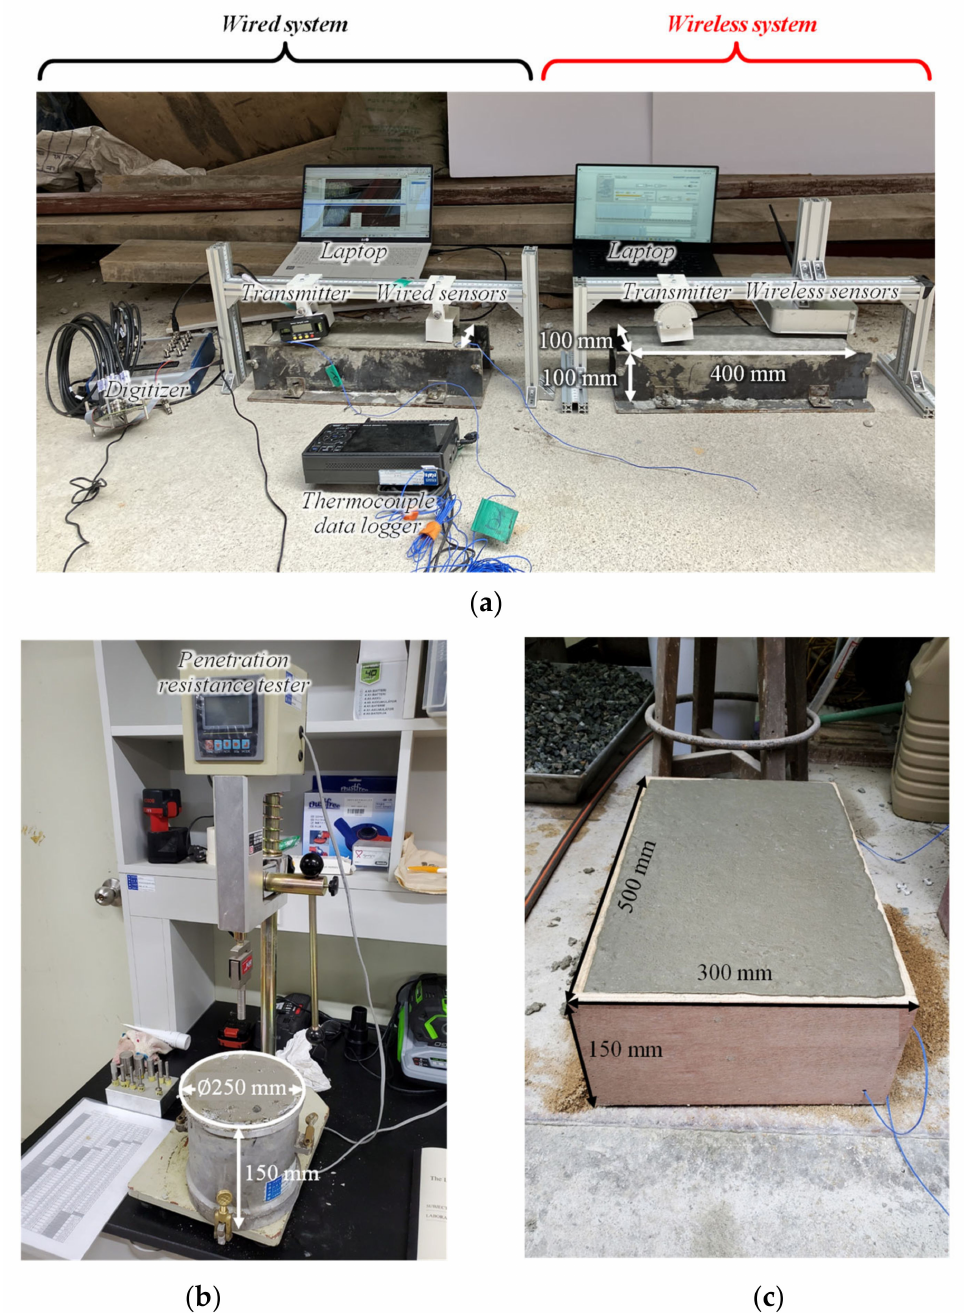
Figure 5. Test setups: ( a ) contactless ultrasonic systems (wired and wireless systems) with thermal gauges, ( b ) pin penetration test setup, and ( c ) a slab specimen for saw